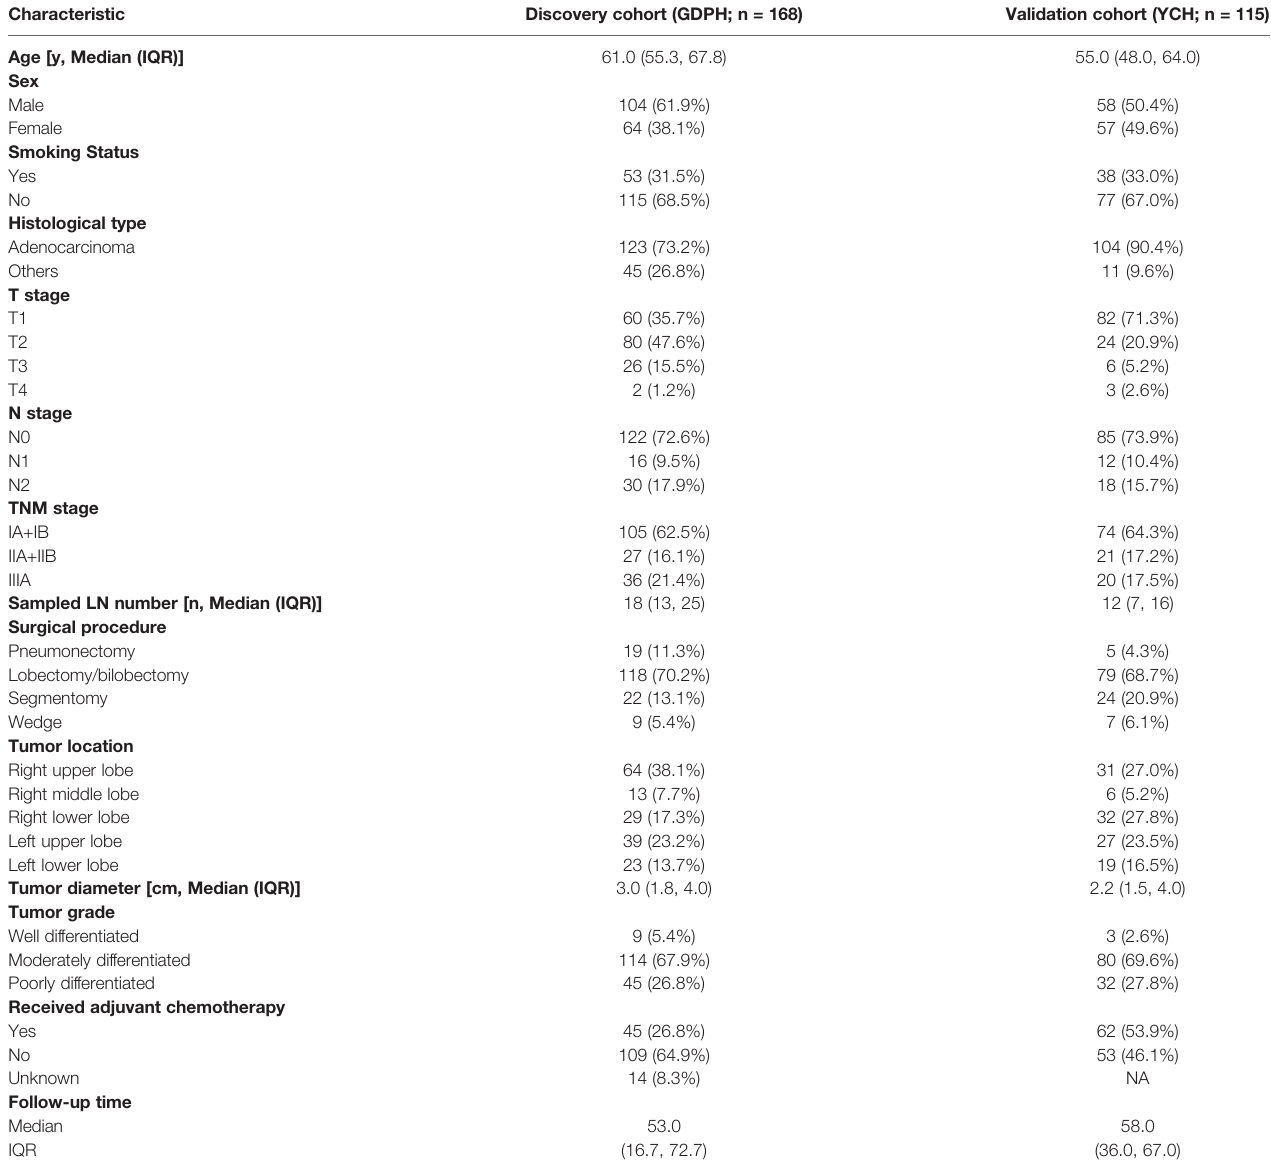
TABLE 1 | Characteristics of patients in the discovery cohort and validation cohort.